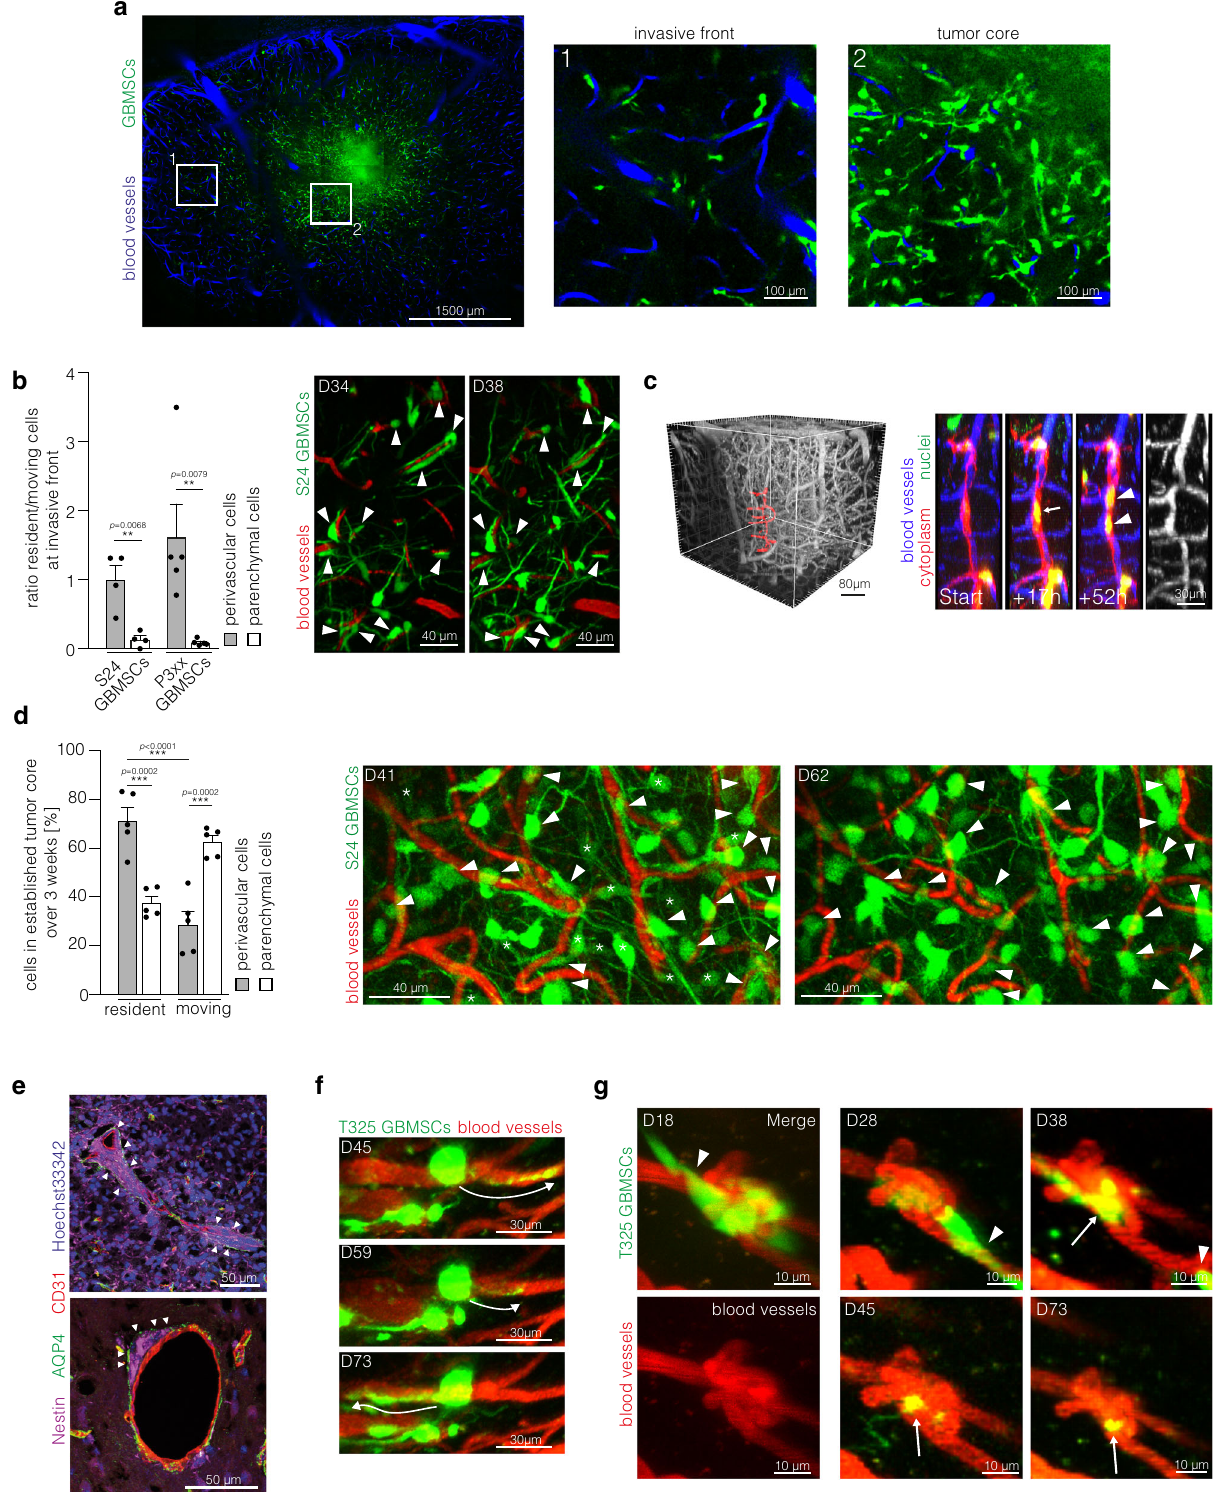
Compared to the TM- and network pro fi cient S24 glioblastoma cells, BT088 oligodendroglioma cells show a higher NOTCH1 expression (Fig. 7a), in line with the suggested role of NOTCH1 for TM network biology. Likewise, by analyzing TCGA gene expression data of molecular glioblastomas vs. oligodendrogliomas 15 , we found a relative downregulation of the NOTCH1 gene and several downstream targets of the NOTCH1 pathway in glioblastoma, as NATURE COMMUNICATIONS| (2021) 12:1014